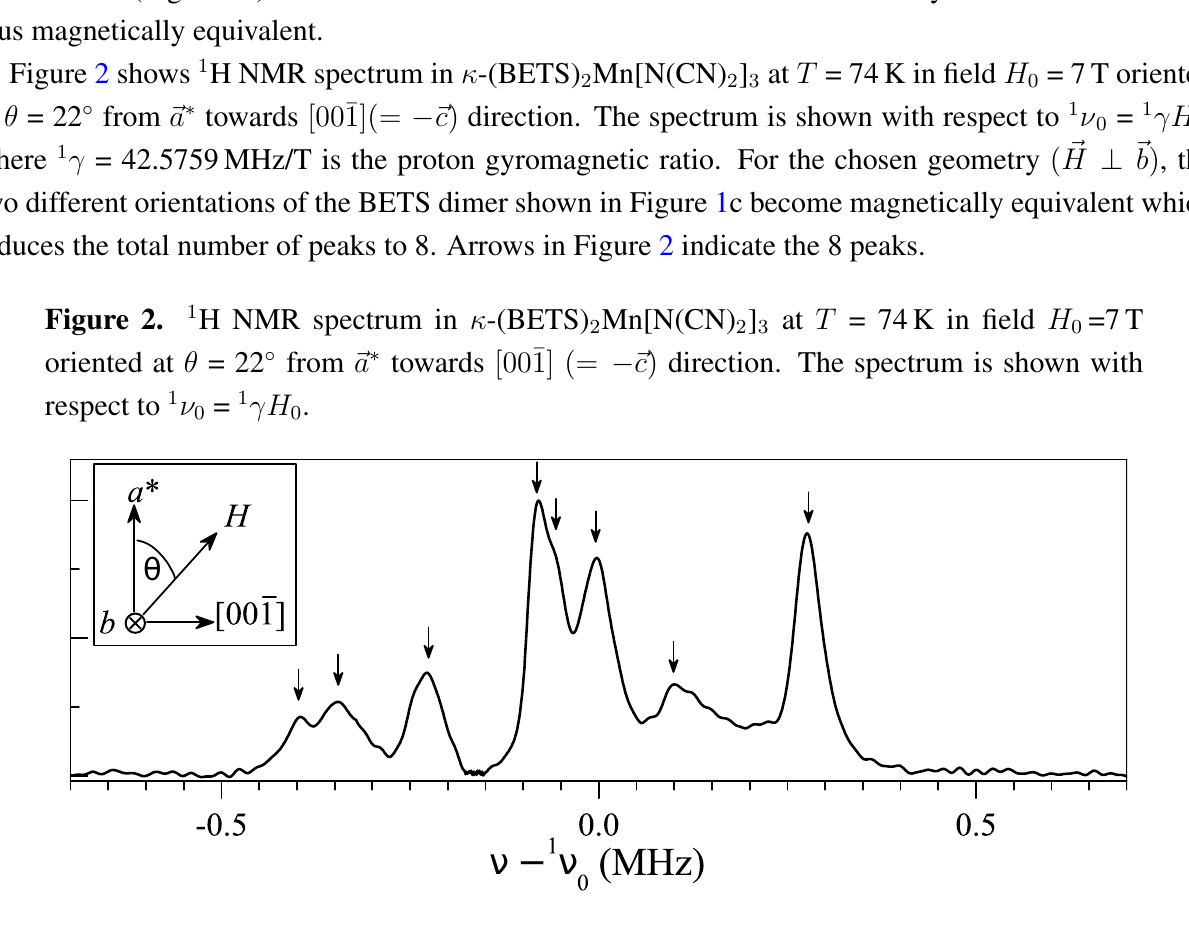
Mn[N(CN) ] at T = 74 K in field H 2 2 3